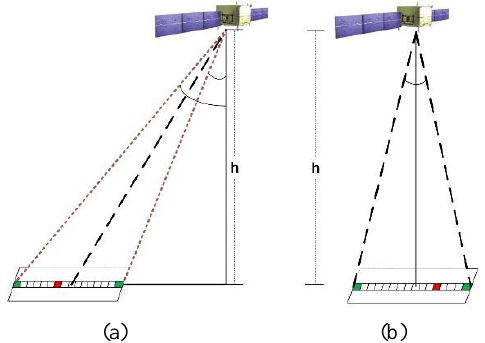
Figure.2 The geometric angle of OLI and WFV1 camera at imaging time (a) WFV1 camera (b) Landsat 8